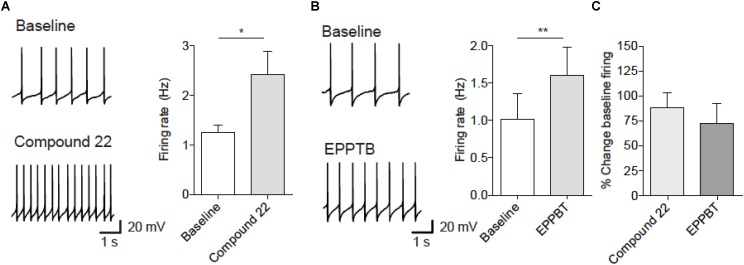
Compound 22 and EPPTB increase spontaneous firing of VTA dopamine neurons. (A) Left, example traces of firing before (upper) or after compound 22 (lower). Right, firing rate significantly increased 5 min after onset of bath application of compound 22 (100 μM) [paired t-test; t(4) = 3.67, ∗p = 0.02, N = 5]. (B) Left, example traces of firing before (upper) or after EPPTB (lower). Right, firing rate significantly increased 5 min after onset of bath application of EPPTB (10 nM) [paired t-test; t(3) = 8.74, ∗∗p = 0.003, N = 4]. (C) Effect size of compound 22 or EPPTB. Bars are mean ± SEM.